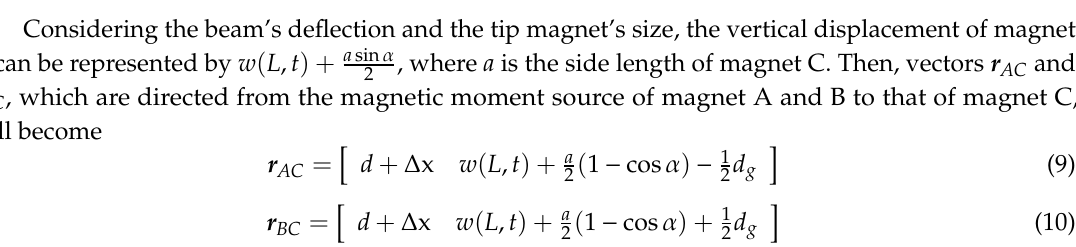
Figure 2. Geometric configuration of the tip magnet and two external magnets.